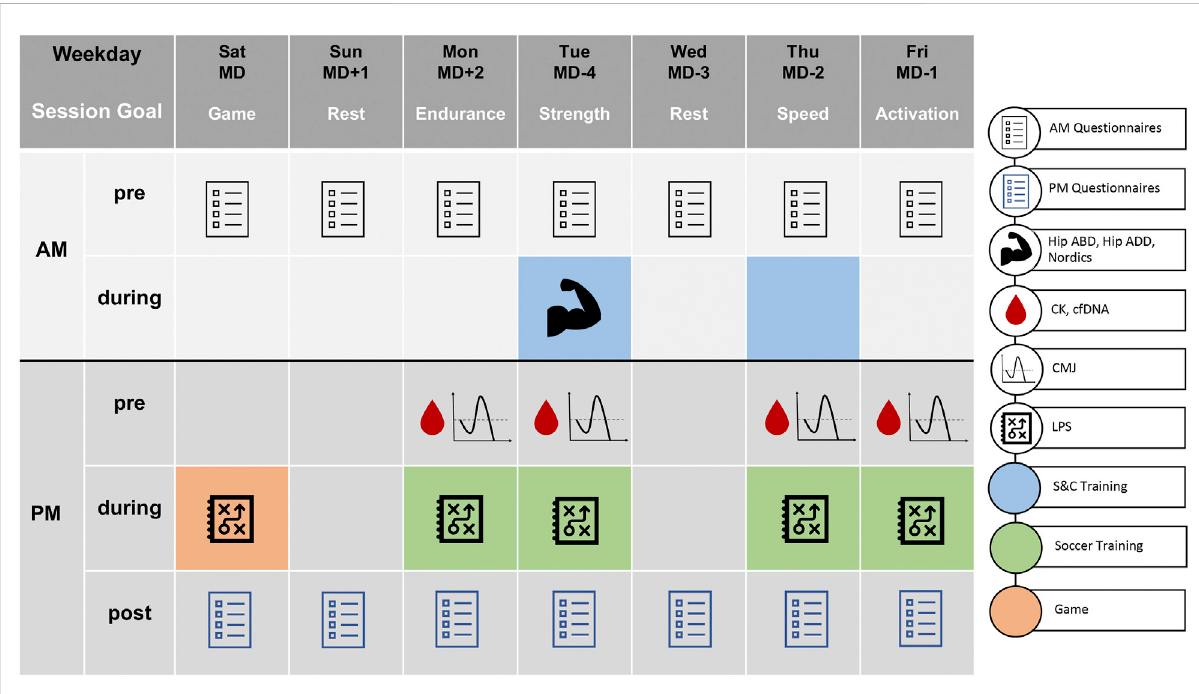
FIGURE 1 Outlineofthemonitoringapproach.Thisexemplaryweekwasrepeatedforall4 weeks.Thelegendontherightillustrateswhichmeasureswere performed on which day. MD = match day, AM = morning, PM = afternoon/evening, pre = before training, during = during training, post = after training, Hip ABD = hip abduction, Hip ADD = hip adduction, Nordics = Nordic hamstring exercise, CK = creatine kinase, cfDNA = cell-free DNA, CMJ = counter-movement jump, LPS = local positioning system (external and internal training load), S&C = strength and conditioning, “ + ” / “ - ” signs clarify the distance in days to regular season